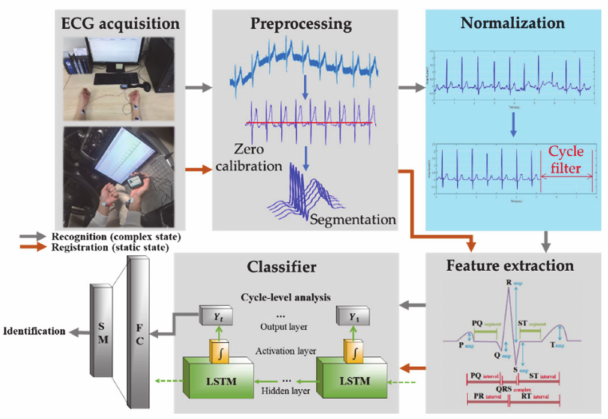
Figure 3. Driver identification and recognition technologies using ECG in vehicle